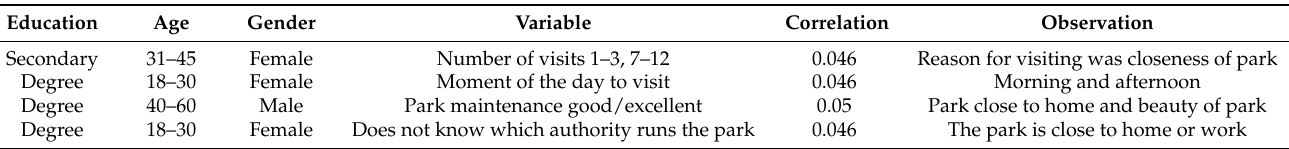
Table 3. Correlation between the study variables of the perception of the visiting population of the Mirador Sur Park.